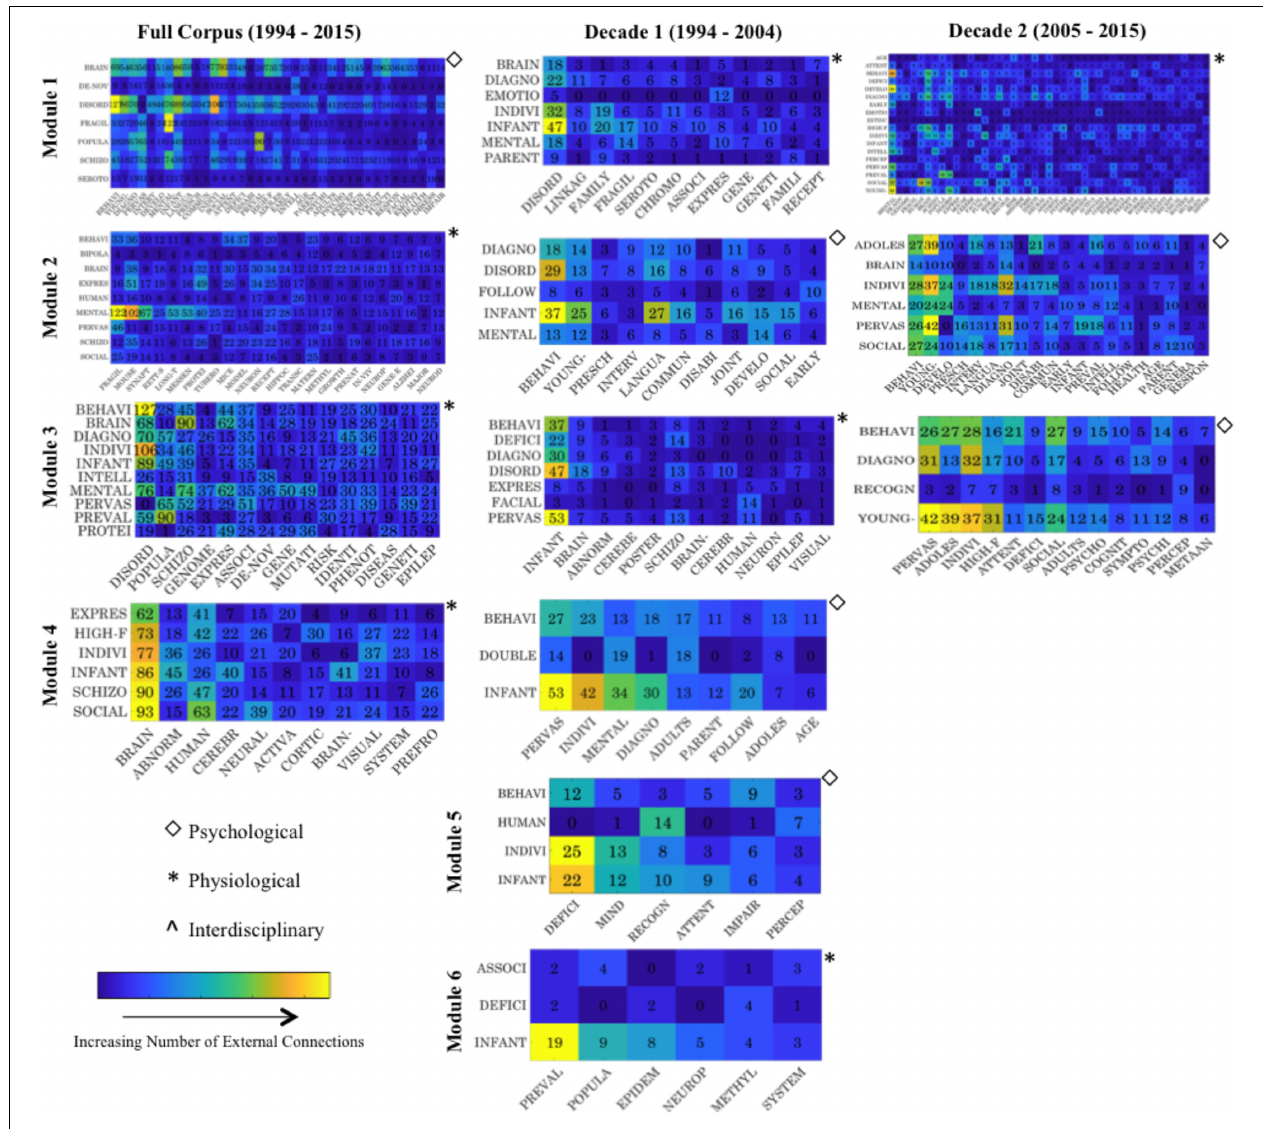
FIGURE 6 | Summary matrices visualizing the external connections between modules within the refined network, i.e., network trimmed of corpus descriptor hubs such as ‘Autism.’ Prominent internal module nodes (keywords) are indicated on the x-axis, while core external partner nodes are represented on the y-axis. Colors are indicative of normalized levels of external connectivity, with lighter colors denoting a larger number of normalized connections (note: original count data is indicated. The left panel provides module networks for the Full corpus, while the two right panels provide those for Decade 1 and Decade 2 respectively). For larger high resolution figures please see